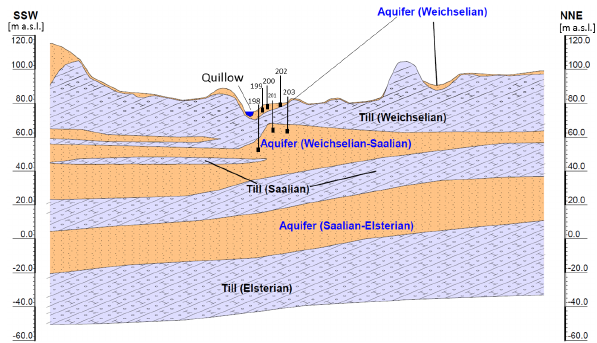
Figure 2. Regional geological profile of the Quillow catchment showing the location and depth of the ZALF’s groundwater obser- vation